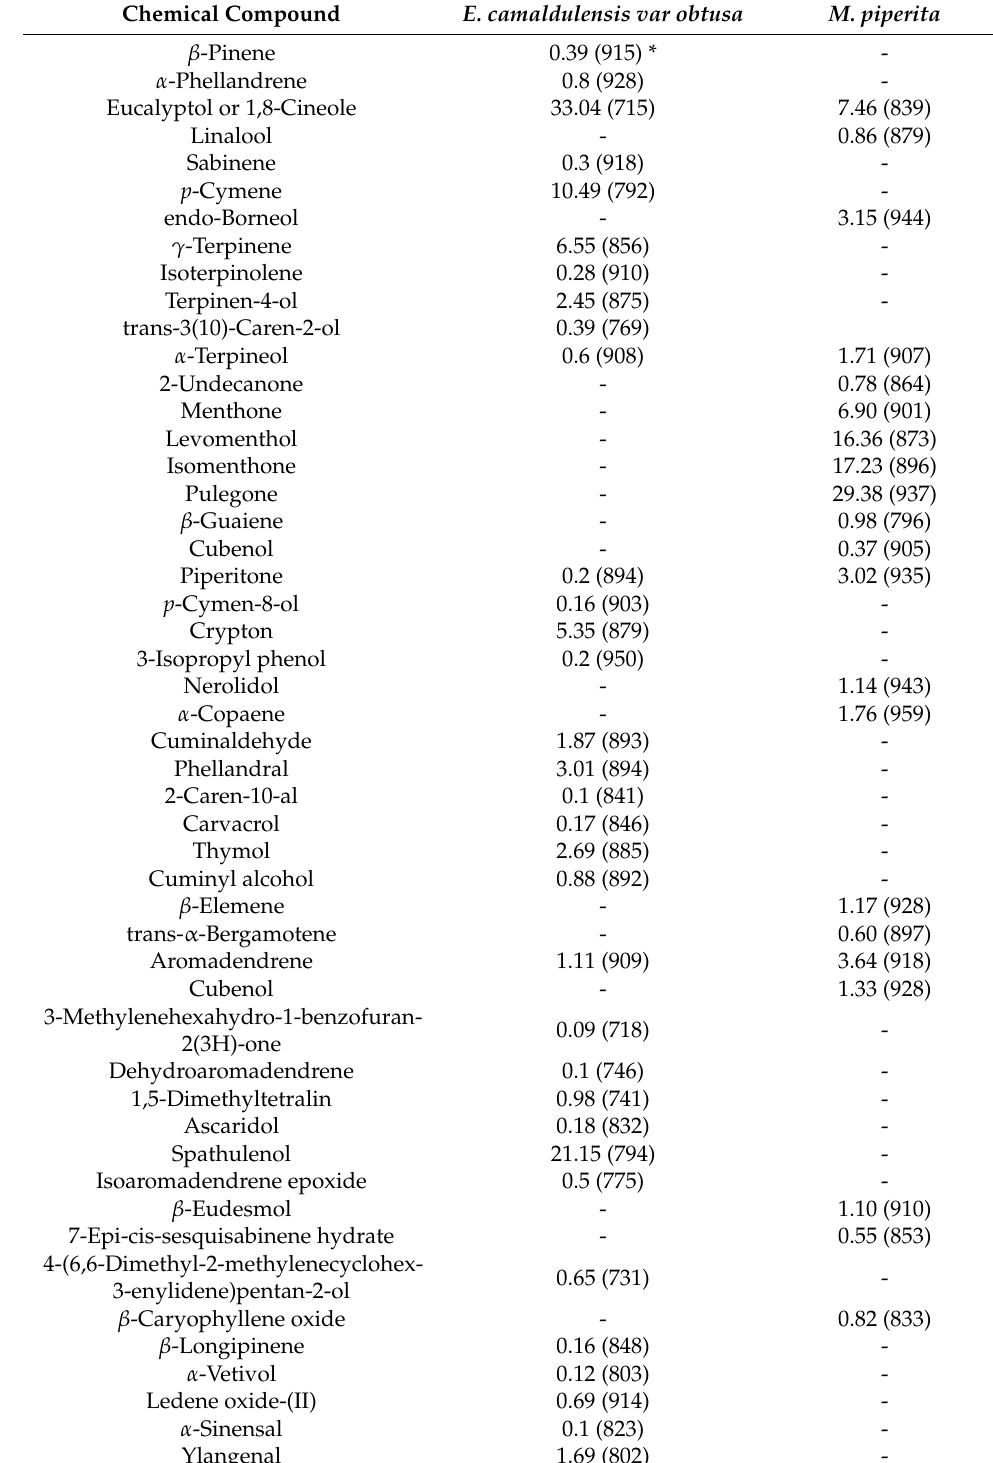
Table 1. Percentages of phytochemical constituents of the essential oils from green aerial parts of E. camaldulensis var obtusa and M. piperita by